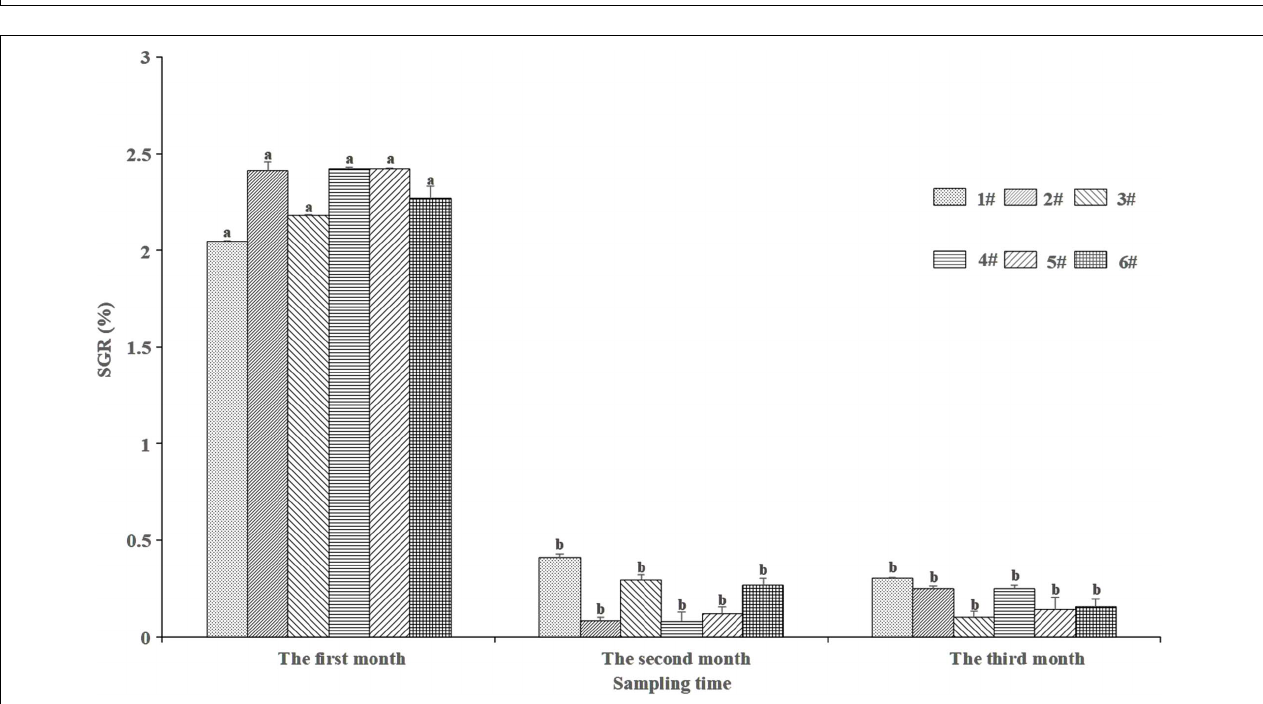
FIGURE 3 | Specific growth rates (SGR) of P. aibuhitensis larvae at different sampling time in sediments. Data with different letters were significantly different in the same sediment. Error bars represent 1 SE.